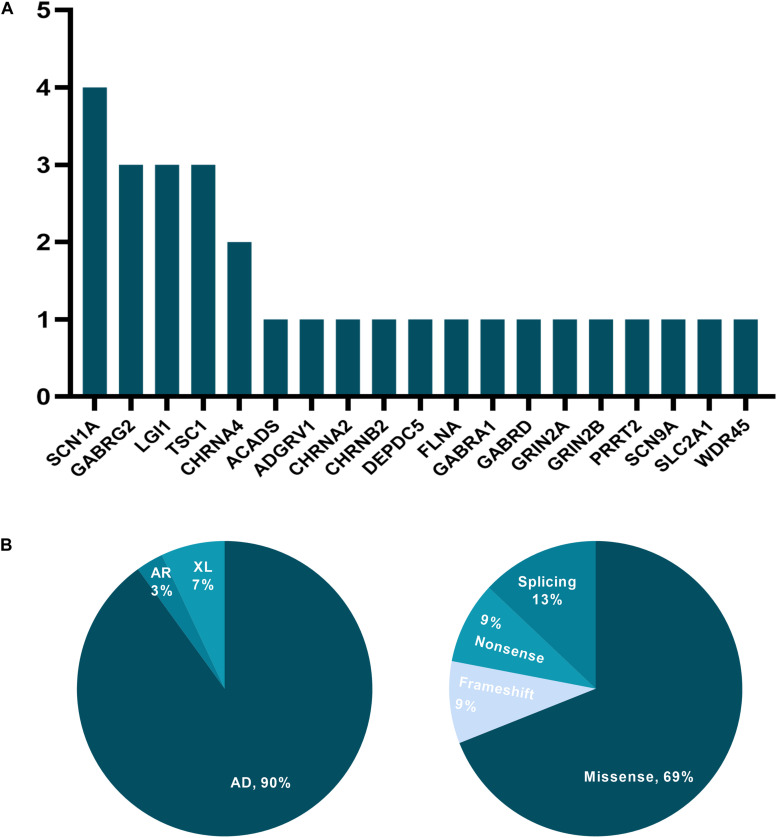
The distribution of mutated genes, mode of inheritance, and variant type for cases with a positive molecular diagnosis. (A)
y-axis: the number of patients; x-axis: genes carrying presumed pathogenic variants. (B) AD, autosomal dominant; AR, autosomal recessive; XL, X-linked disorders.